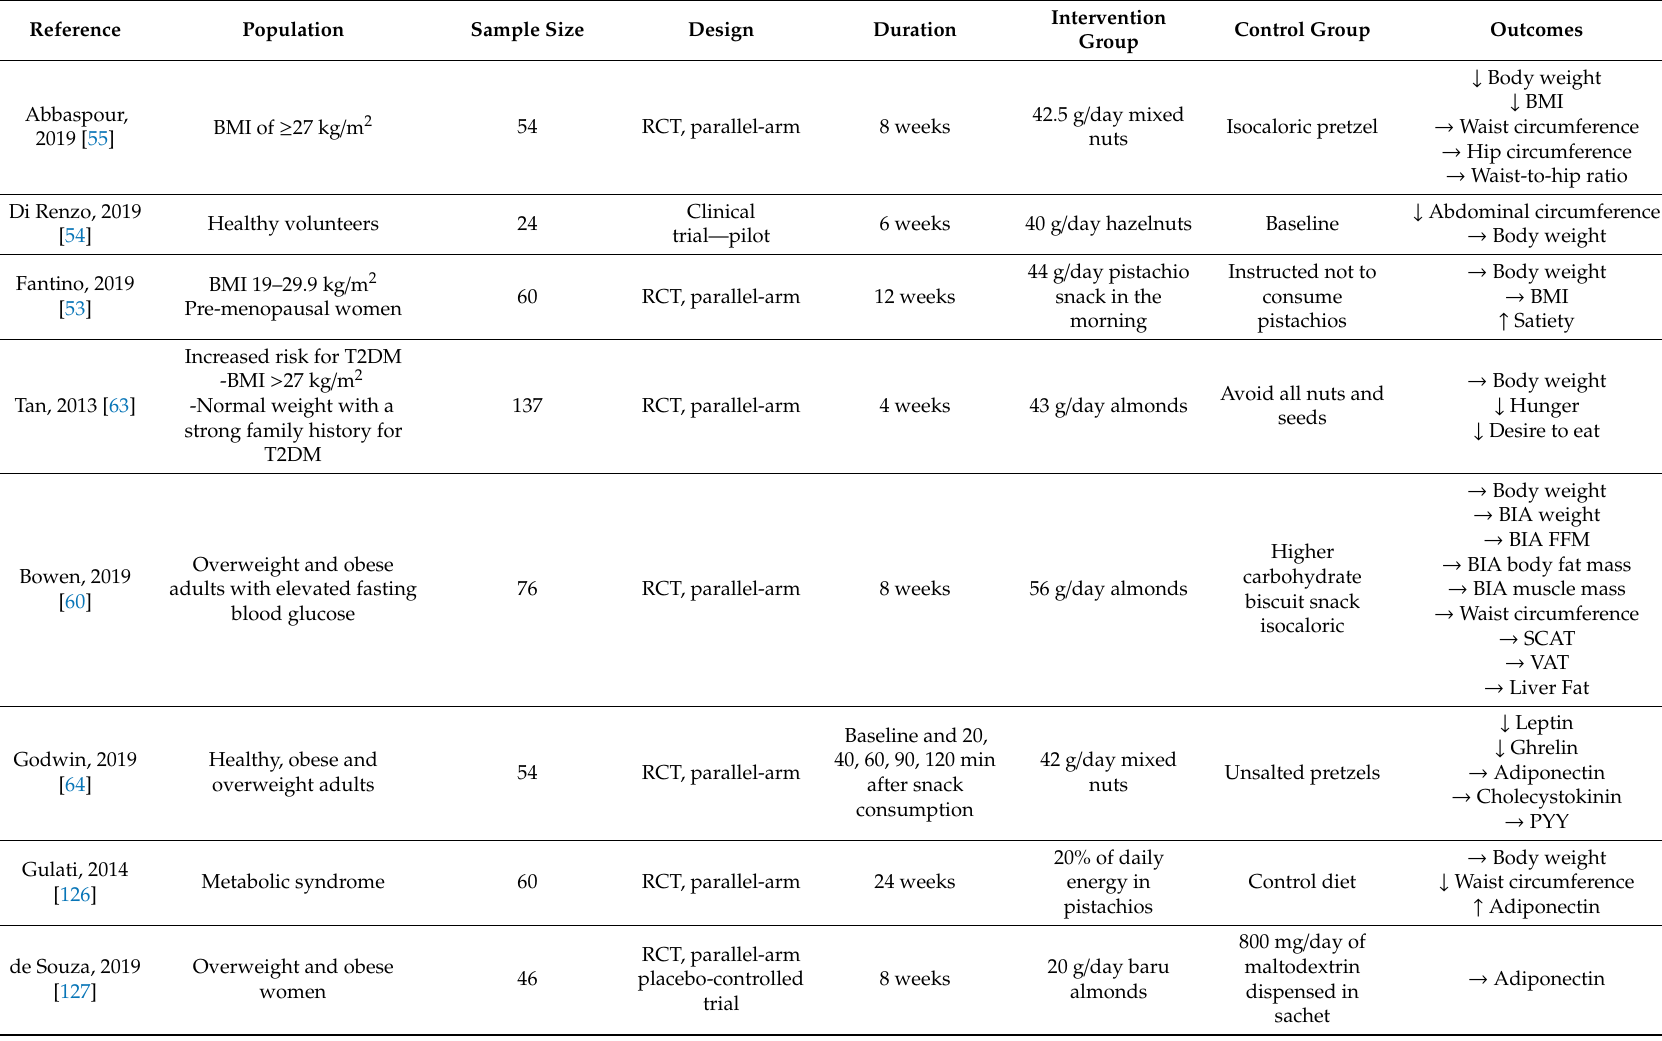
Table 2. Clinical trials that evaluated the e ff ect of di ff erent nuts on indexes of adiposity, adipokines, and other parameters related to body weight